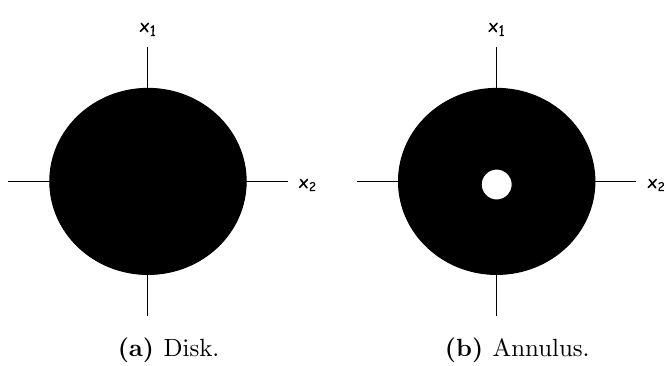
Figure 1 . LLM con(cid:12)gurations in the ( x 1 ; x 2 ) plane. The con(cid:12)gurations describe boundary con- ditions for the equations of motion on a two dimensional surface in the bulk spacetime, and also correspond to con(cid:12)gurations in a fermionic phase space that completely summarizes the boundary 1 = 2 BPS state. The black disc boundary condition (a) leads to a pure AdS 5 (cid:2) S 5 geometry. We will show that no entangling surface can probe deeply into the IR region of the geometry given by the annulus boundary condition